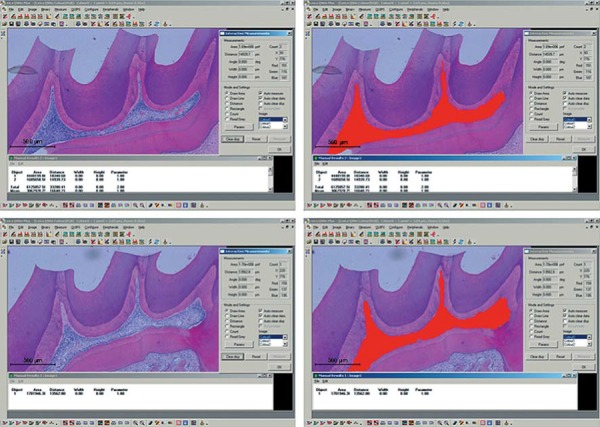
Central area measurement of the pulp chamber in the experimental groups using the Leica QWin V3 Image Processing and Analysis Software (Leica Microsystems, Wetzlar, Hesse, Germany). The values obtained were analyzed by the Kolmogorov-Smirnov normality test and the one-way analysis of variance (p<0.05)